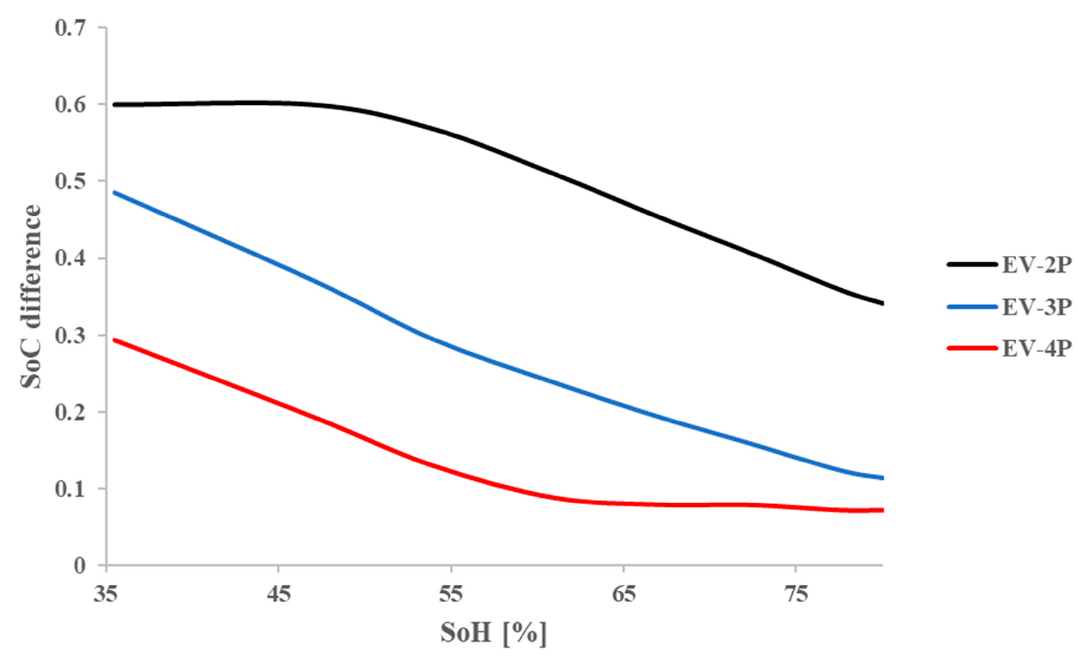
Figure 16. The SoC difference in different second life batteries discharge cycles for various scenarios.